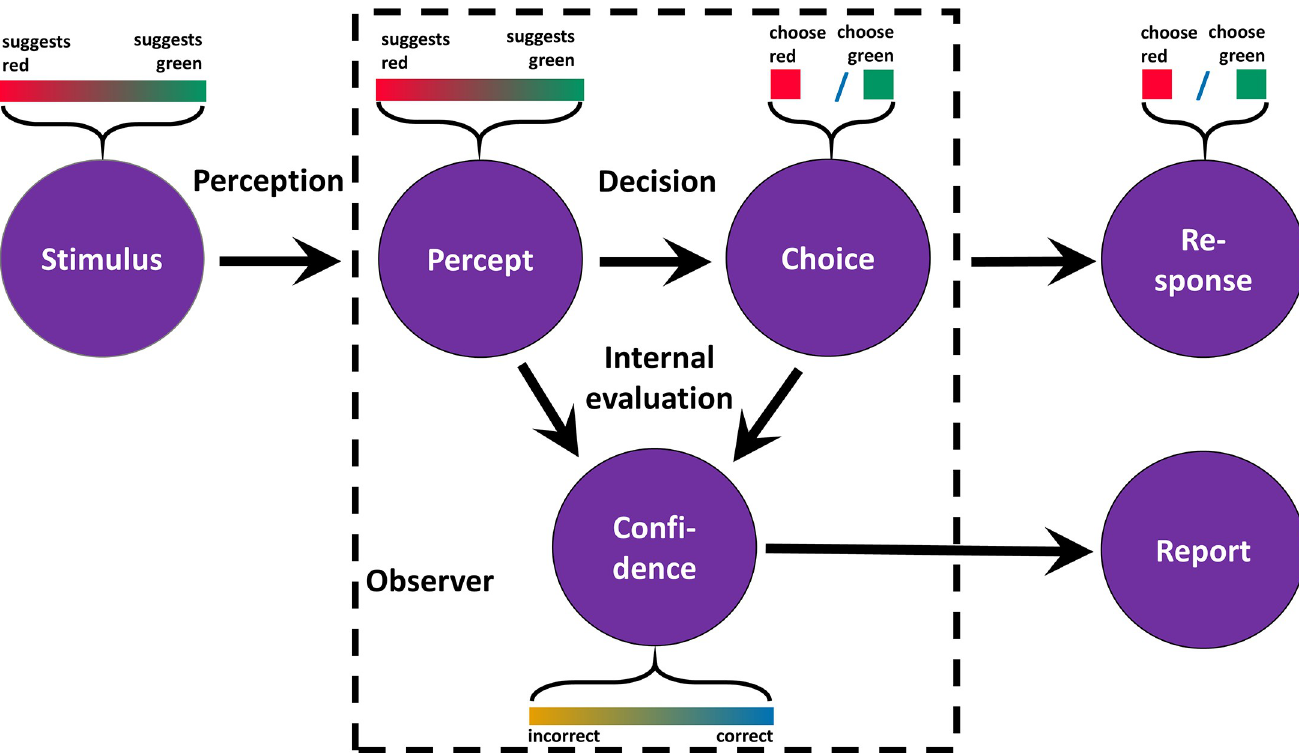
Fig 1. The standard model of confidence. The stimulus objectively supports the choice options”red” and “green” to varying degrees. As perception is noisy, the percept is a corrupted representation of the degree to which the stimulus favours a specific choice option. Confidence is the probability of making the correct choice given percept and